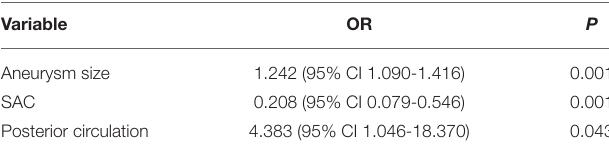
TABLE 2 | Result of multivariate analysis. TABLE 3 | Summary of model